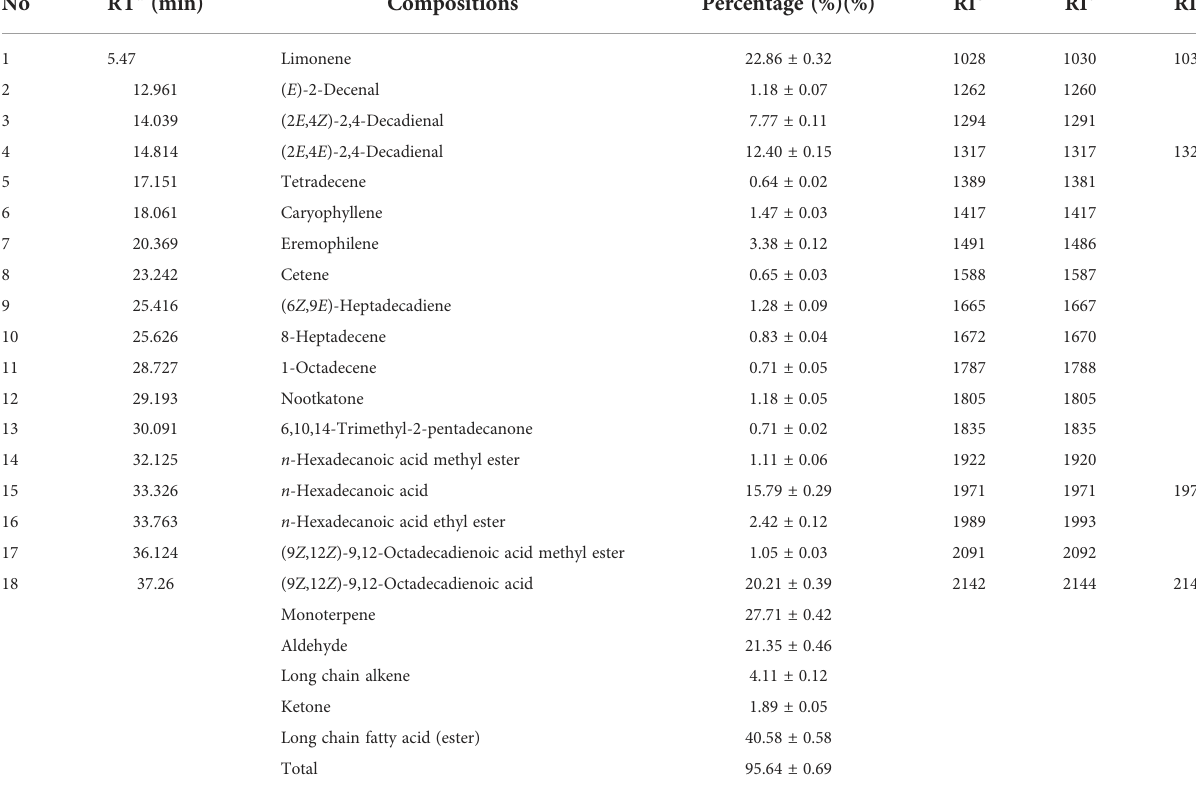
TABLE 3 Chemical compositions of PSO (pomelo seed oil) by GC-MS.